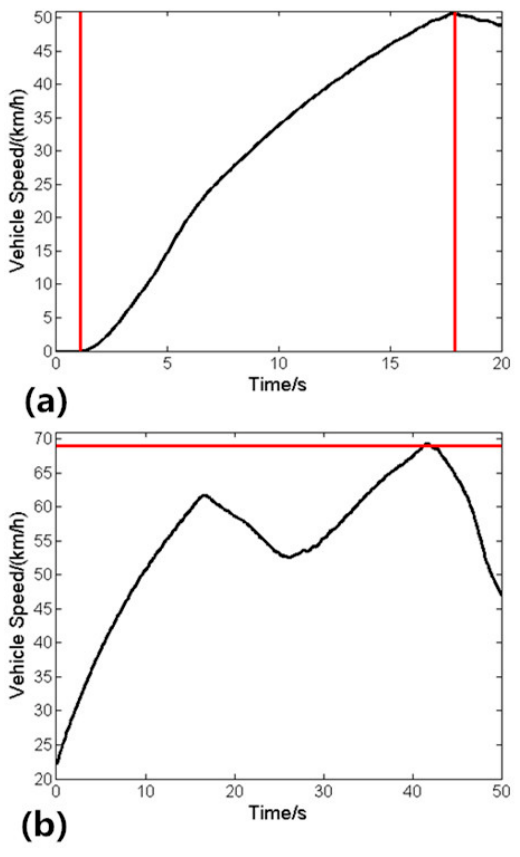
Figure 12. ( a ) Acceleration performance; ( b ) Maximum speed performance.